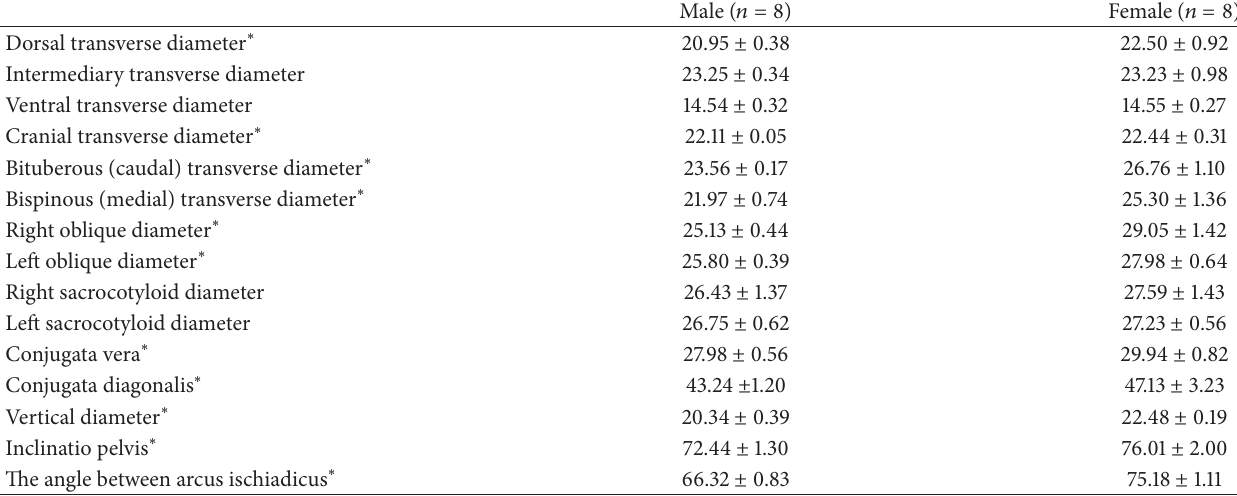
Table 1: Statistical results of biometric measurements belonging to pelvic cavity obtained as a result of 3D reconstruction (mm ± SD).